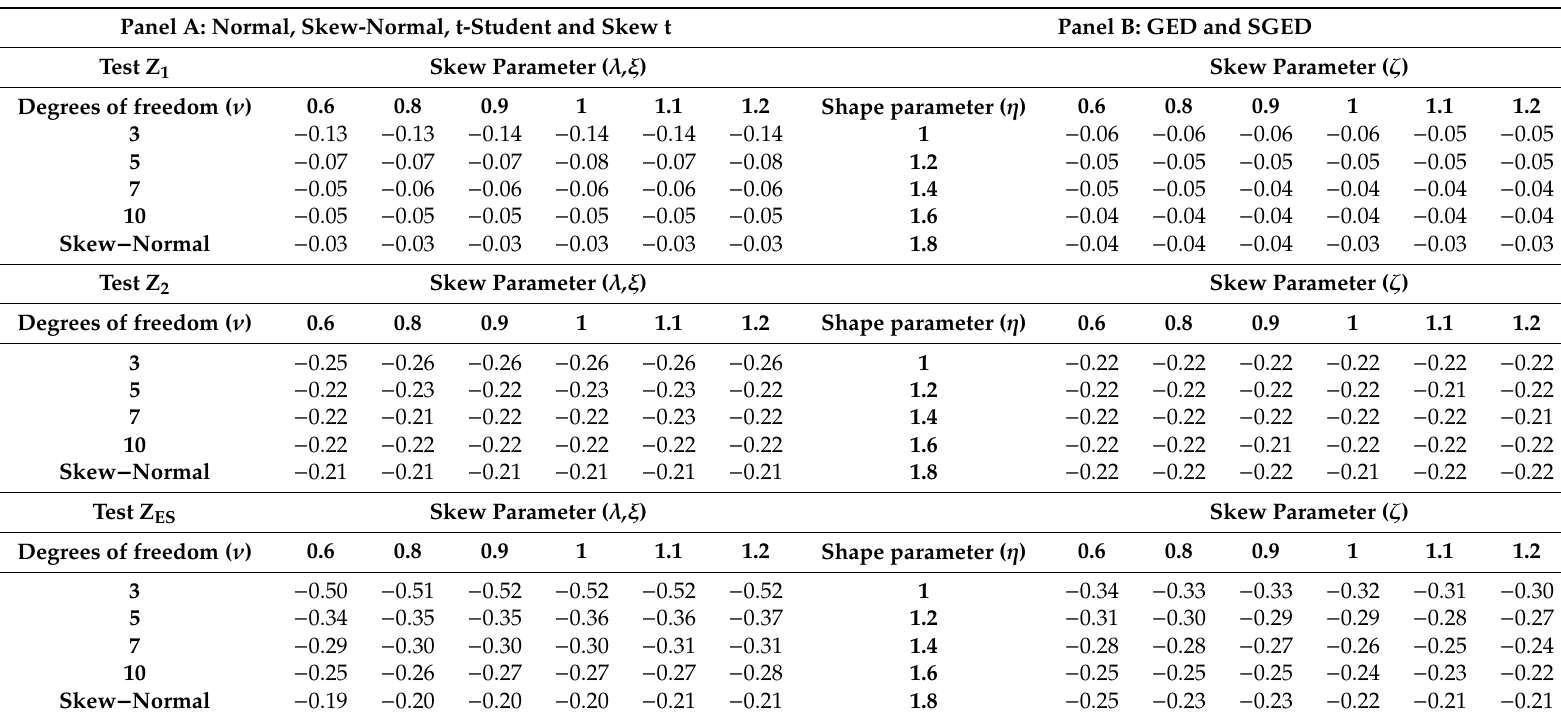
Table 1. Selection of critical values for Z 1 , Z 2 y ZES tests, and di ff erent distributions. T = 2400 and significance level of 5%. Panel A: Normal, Skew-Normal, t-Student and Skew